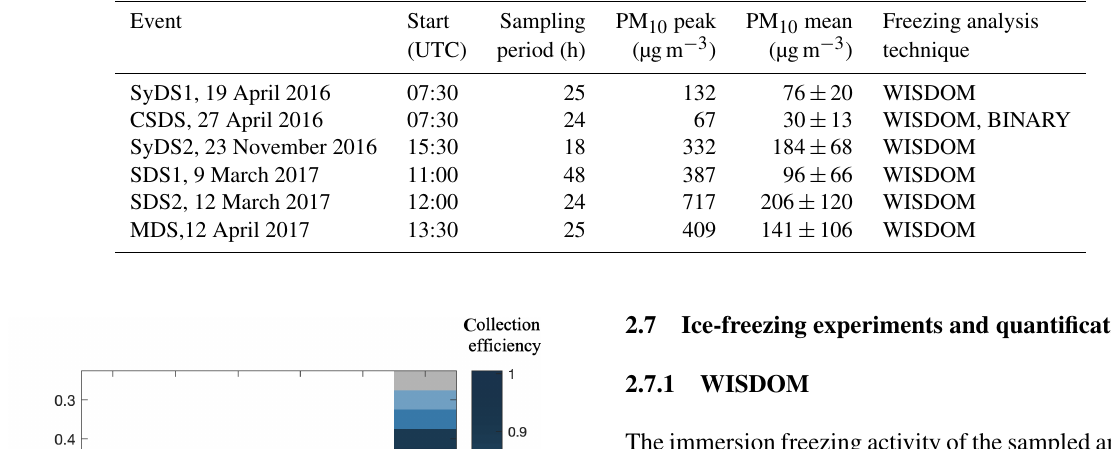
Table 1. Summary of the investigated dust storm events. The events are denoted by their geographic origin: Saharan dust storm (SDS), Syrian dust storm (SyDS), mixed contribution of the two (MDS) and mix of dust event with a dust-free period (CSDS).